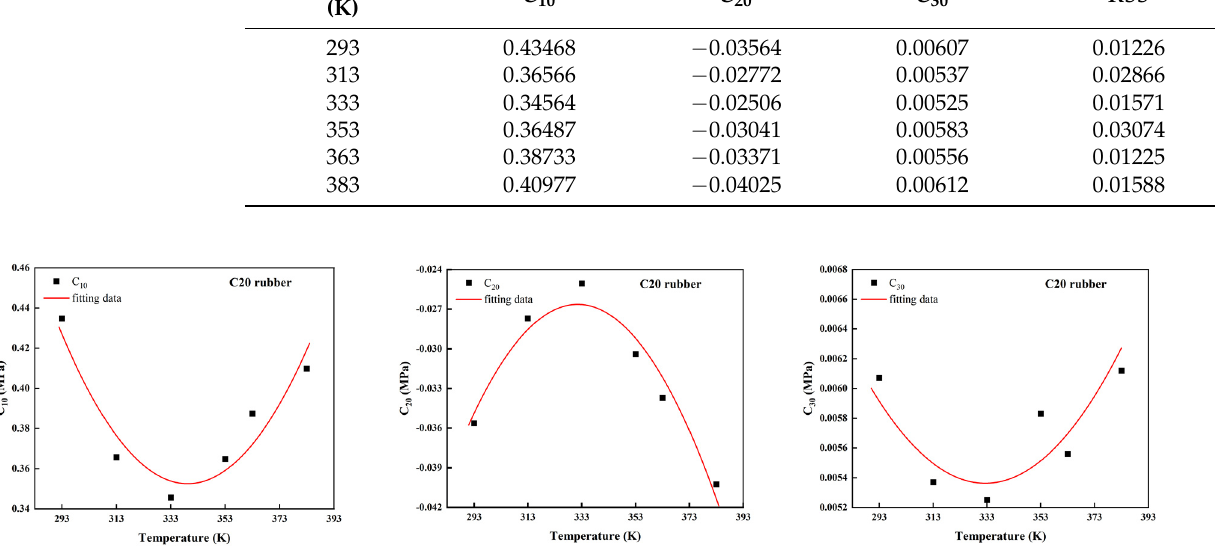
Figure 5. Trends of parameters for the uniaxial tensile data of the C20 rubber specimen at different temperatures by the Yeoh model.